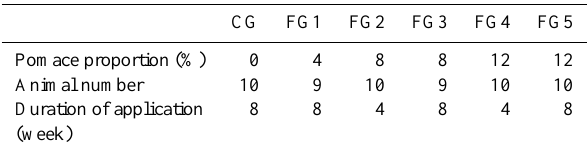
Table 2. Experimental